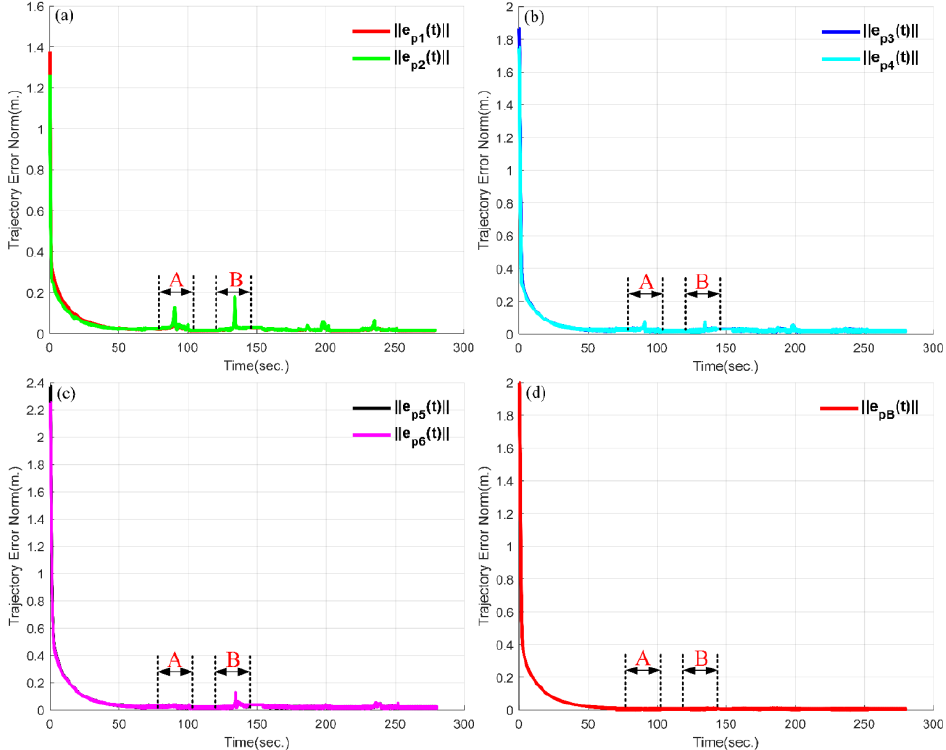
Figure 7. Asymptotic stability analysis and tracking accuracy analysis in S-curve terrain scenario. Subfigure ( a ) indicates the error norms of the front flipper. Subfigure ( b ) indicates the error norms of the middle flipper. Subfigure ( c ) indicates the error norms of the rear flipper. Subfigure ( d ) indicates the error norm of the center of mass. A indicates that the increase of error norm is due to the robot in a raised pose at the climbing end stage. B indicates that the increase of error norm is due to the rapid drop of the robot under the effect of gravity.